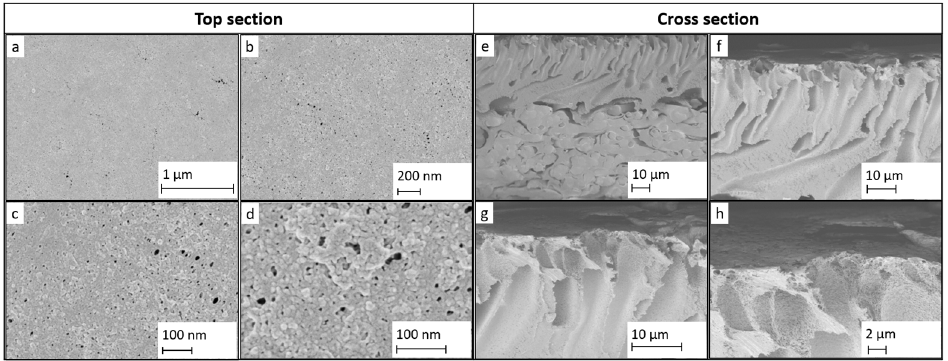
Figure 2. SEM micrographs of Membrane A. ( a – d ) top view of the membrane surface with different magnifications; ( e – h ) cross sections at different locations.